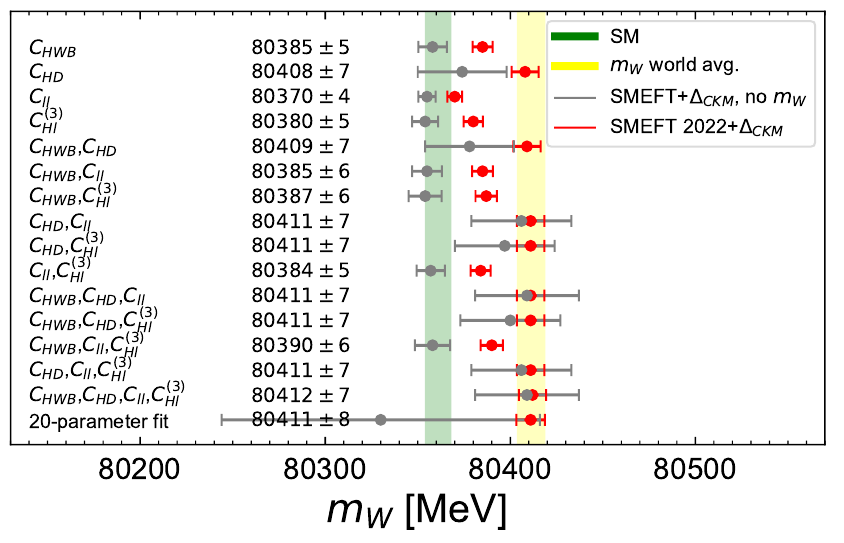
Figure 7 . Values of m W in fits including all combinations of operators entering linearly in m W , including from 1 to 4 operator ceofficients, as well as a fit to 20 operator coefficients. Results omitting direct measurements of m W but including ∆ CKM are shown in grey, and results with ∆ CKM and using the current world average of m W measurements including that by CDF are shown in red. The vertical green band is the SM prediction for m W based on a SM electroweak fit excuding m W and ∆ CKM , and the yellow band is the current world average of m W